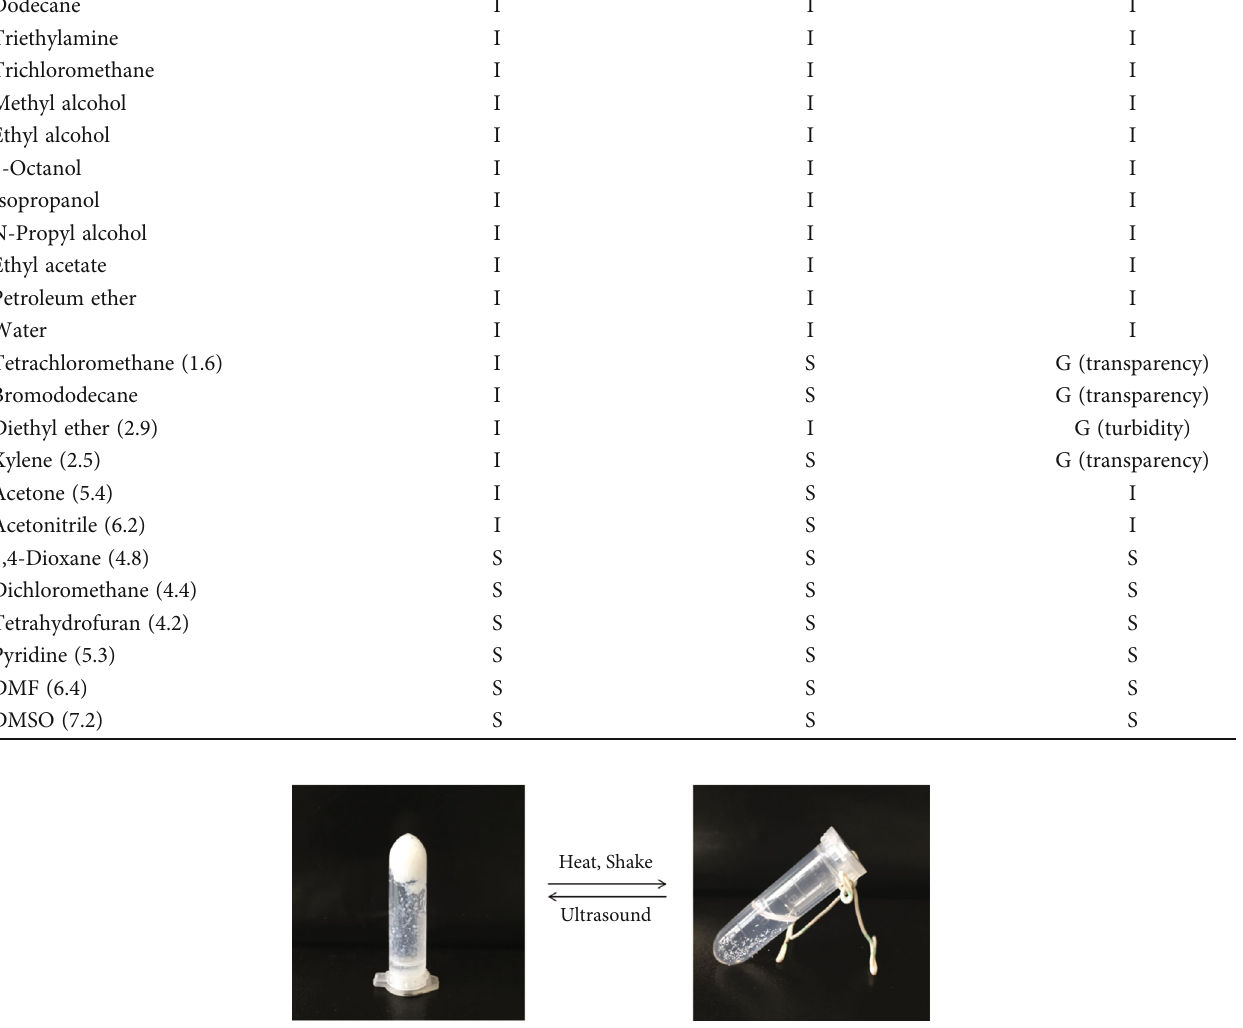
Figure 4: Changes of DMTCP (diethyl ether)